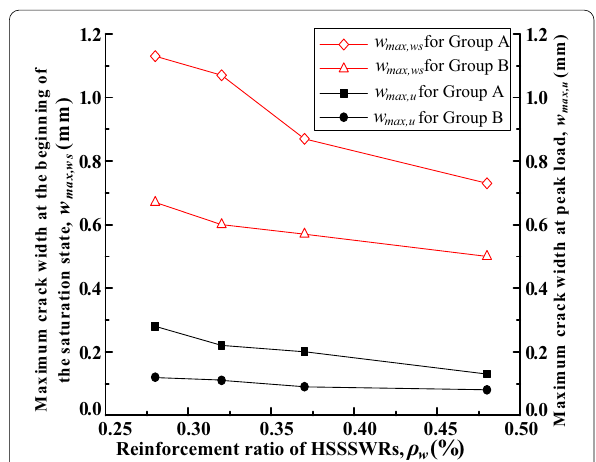
Fig. 9 Relationship of crack-width and reinforcement ratio of